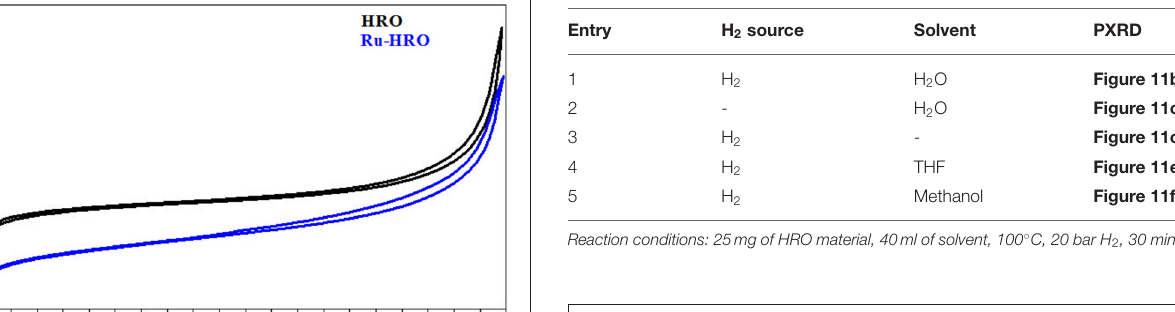
carbonyl group of the sugar molecule (HC = O) to